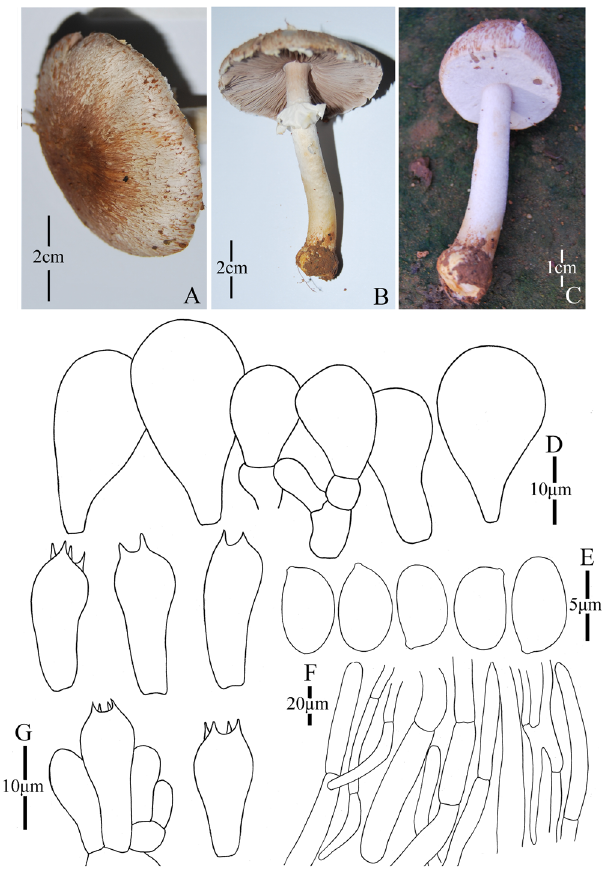
Figure 5. Morphology of Agaricus bonussquamulosus ( ZRL2010106 , holotype), ( A – C ): Basidiome in field ( ZRL2010106 ), ( D ). Cheilocystidia, ( E ). Basidiospores, ( F ). Pileipellis hyphae, and ( G ):